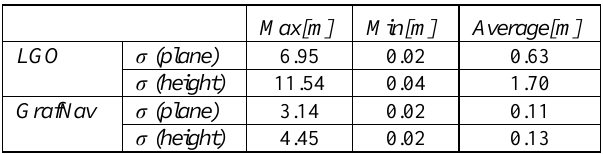
Table 2. Standard deviations σ of the coordinate solutions achieved in LGO and